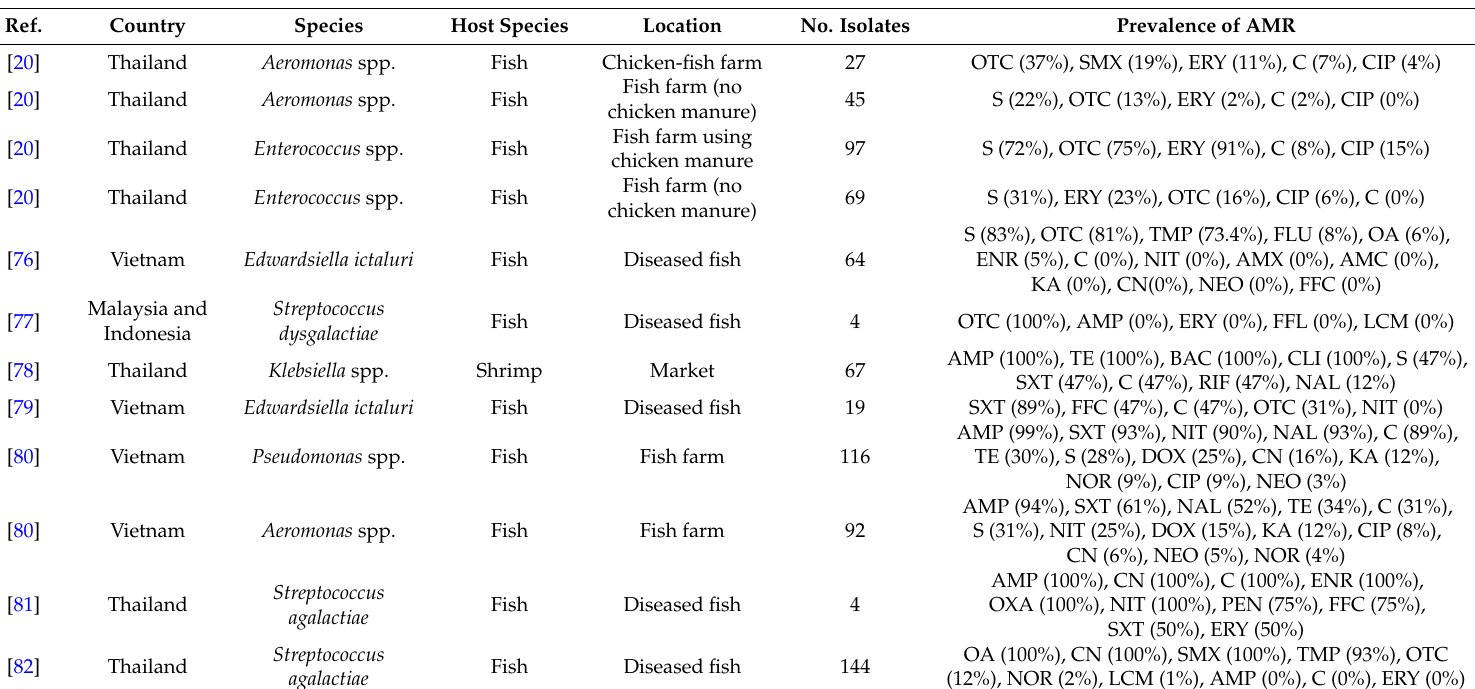
Table 3. Summary of phenotypic prevalence of AMR in bacteria isolated from aquaculture products (data extracted from eight publications).